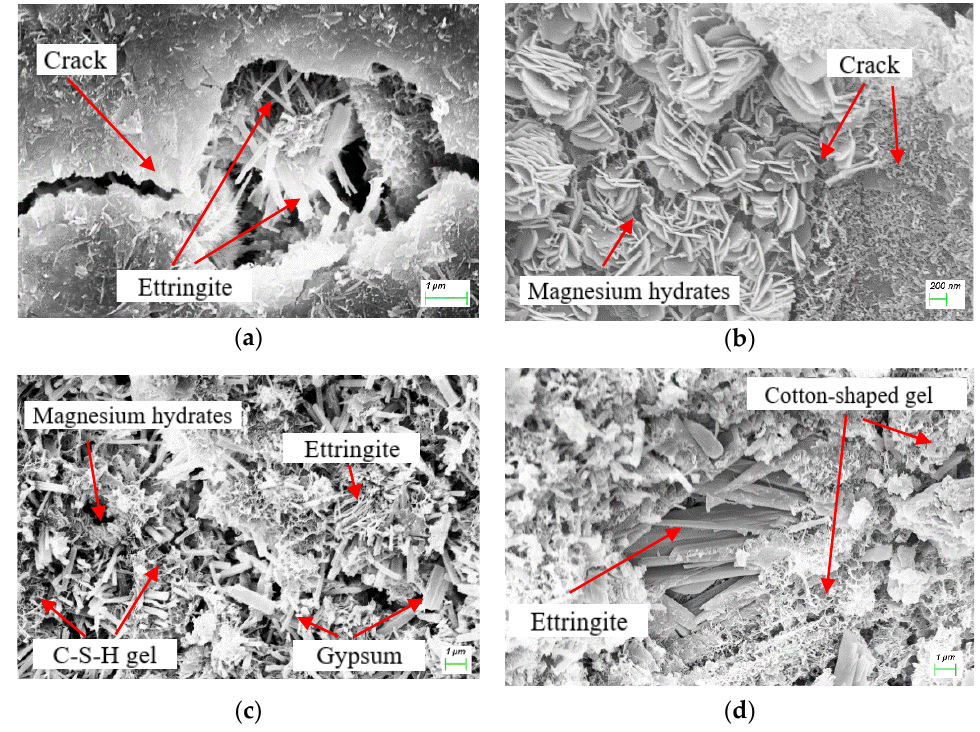
Figure 7. SEM results for specimens: ( a ) E-IS, ( b ) E-ISM, ( c ) E-ISMG and ( d ) E-ISMG.